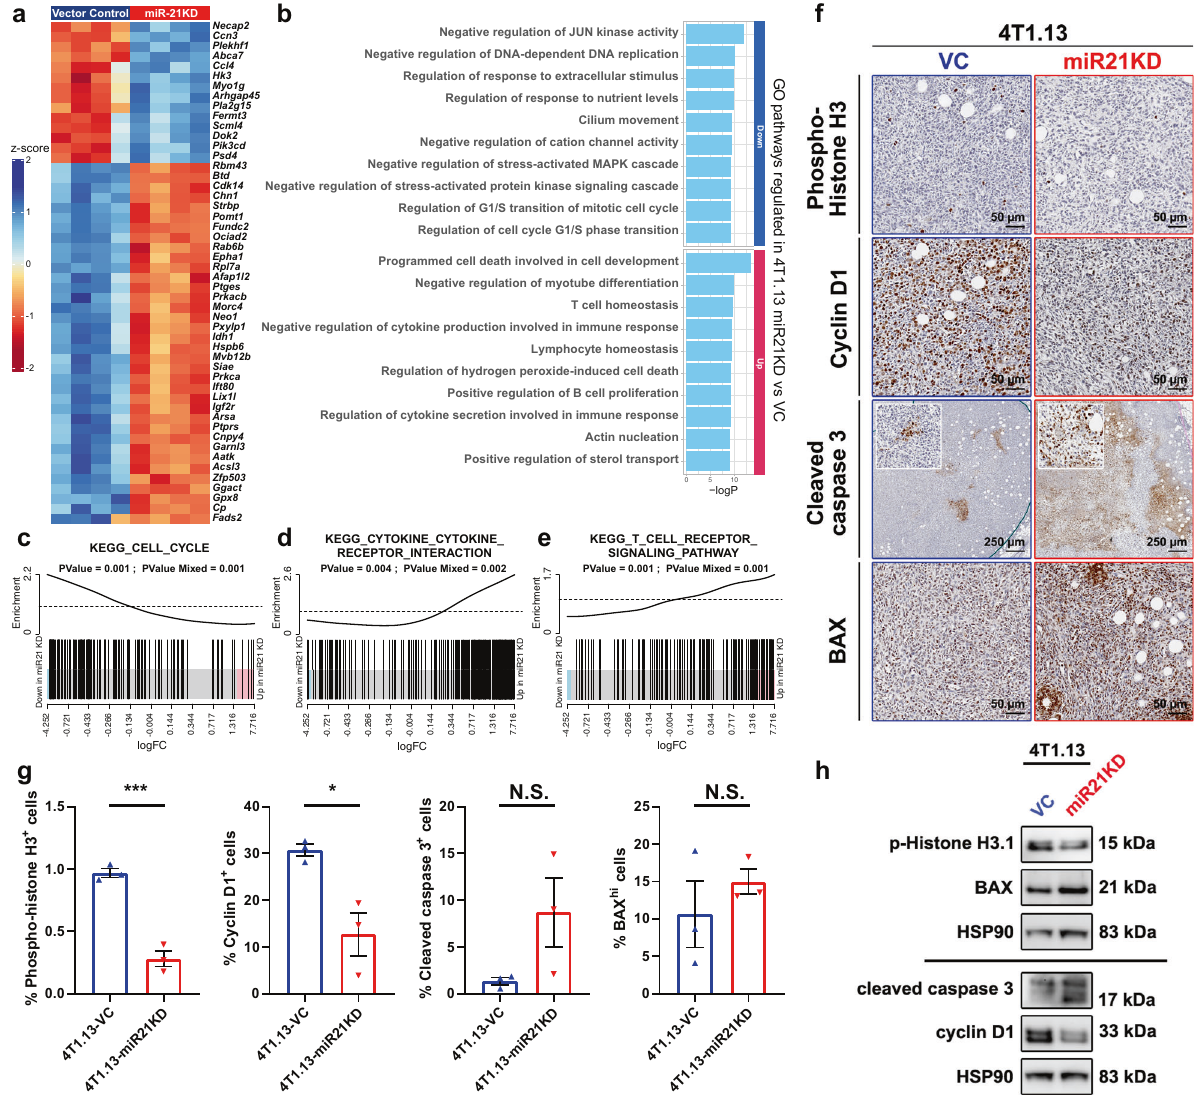
Fig. 5 Gene expression pro fi ling of whole primary tumours derived from 4T1.13-VC and 4T1.13-miR-21-KD cells. a Heat map showing the top 50 differentially expressed genes between 4T1.13-VC and 4T1.13-miR-21-KD tumours from RNA sequencing analysis. b Up-regulated and down-regulated Gene Ontology (GO) terms enriched in 4T1.13-miR-21-KD compared to 4T1.13-VC tumours, derived from the RNA sequencing data. c - e Barcode plots showing the signi fi cant down-regulation of genes involved in cell cycle activity ( c ), and upregulation of genes involved in cytokine-cytokine receptor interaction ( d ) and T cell receptor signalling ( e ) in the 4T1.13-miR-21-KD tumours. f IHC analysis of the levels of cell cycle- and apoptosis-related proteins in 4T1.13 tumours with or without miR-21 knockdown. Based on the bioinformatics analysis, cyclin D1 was down-regulated and BAX was up-regulated when miR-21 activity was reduced. g Quantitation of IHC staining levels in ( f ) using the Aperio digital pathology system. Mean ± SEM ( n = 3 tumours/group). * p < 0.05; *** p < 0.001; N.S., not signi fi cant. h Western blot analysis of the expression of cell cycle- and apoptosis-related proteins in 4T1.13 cells cultured in